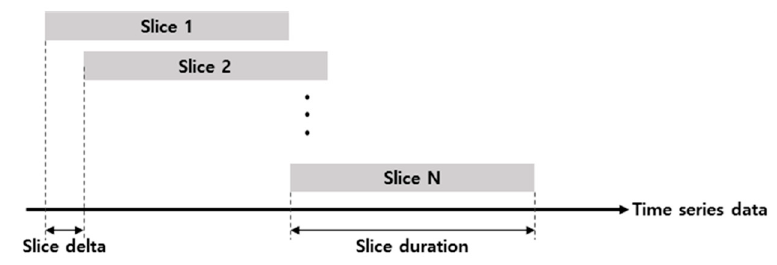
Figure 4. Sliding Window Figure 4 . Sliding Window Method. Figure 4 . Sliding Window Method.